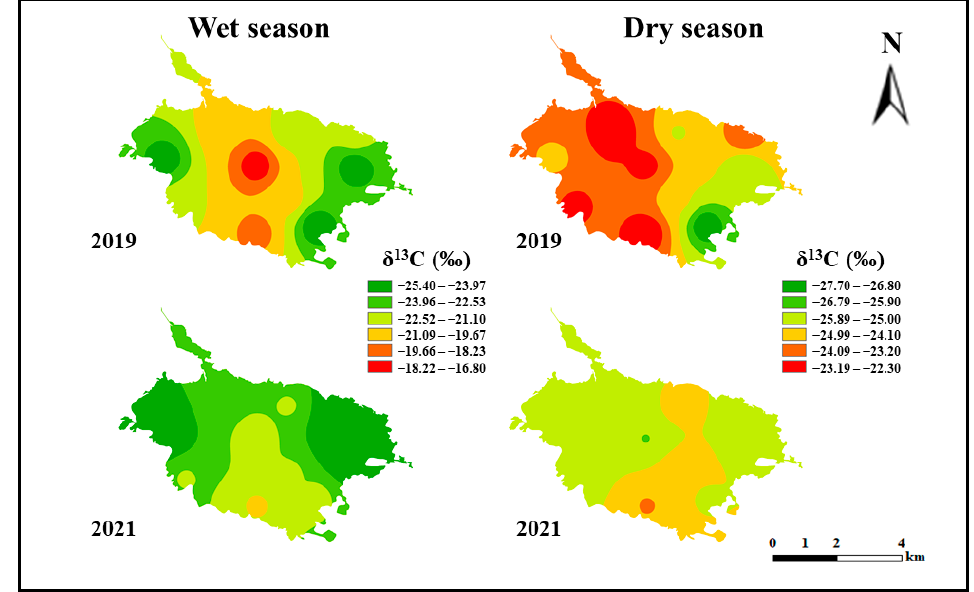
Figure 5. Temporal and spatial variation of carbon stable isotope in wet season and dry season of Caohai Lake.